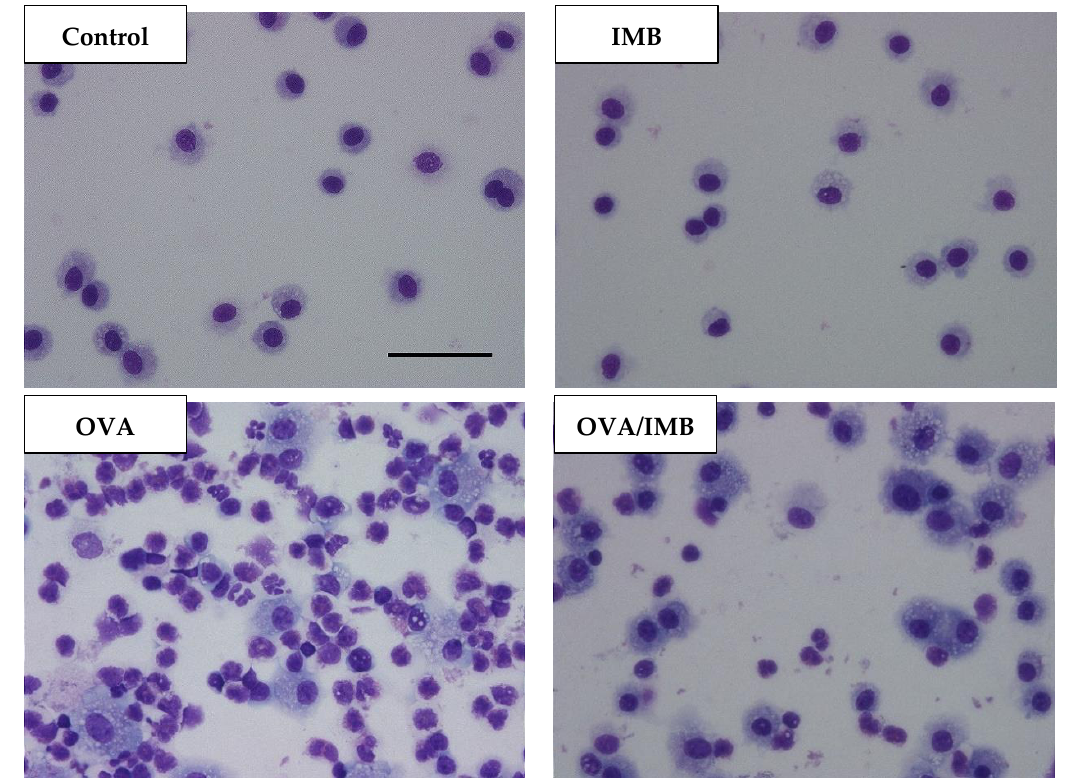
Figure 3. Representative images of BALF from each group are shown at 400 × magnification. Scale bar = 50 µ